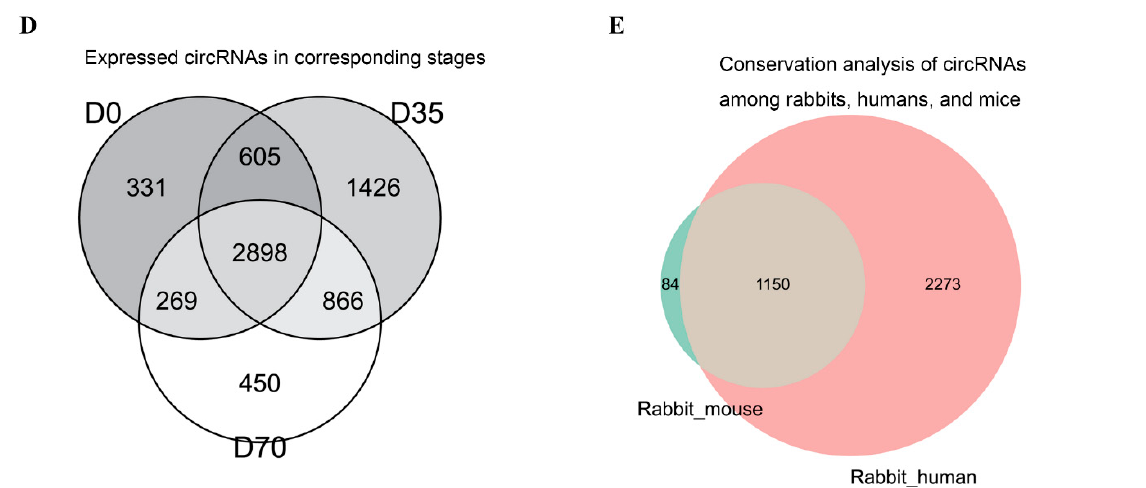
Figure 3. Characterization of circRNAs in skeletal muscle tissues. ( A ) Genomic distribution of circRNAs. ( B ) The number of circRNAs with different exon counts. ( C ) The length distribution of circRNAs. ( D ) Venn diagram of the expressed circRNAs in D0, D35, and D70. ( E ) The number of conserved circRNAs between rabbits and mice, and between rabbits and humans.